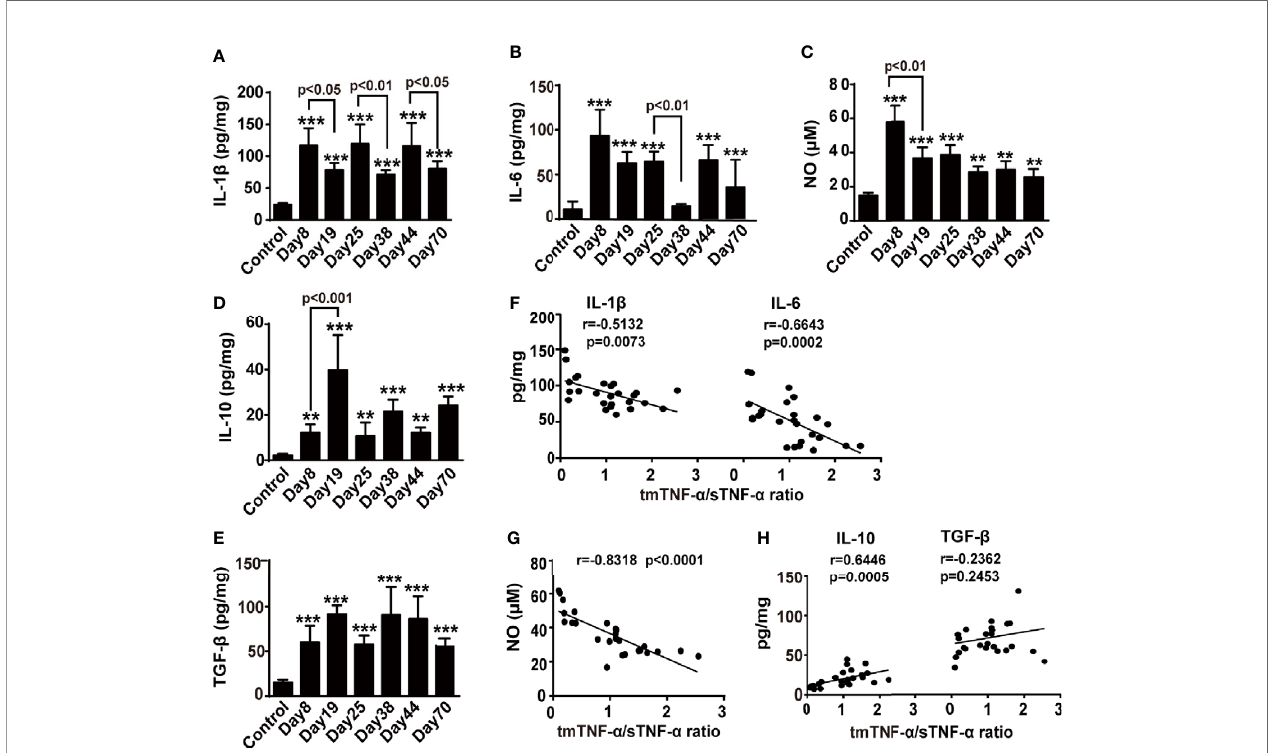
FIGURE 4 | The tmTNF- a /sTNF- a ratio negatively correlates with proin fl ammatory mediators but positively correlates with IL-10. Mice were treated with AOM and DSS as described in Figure 1A (n = 5-8, each group). Concentrations of IL-1 b (A) , IL-6 (B) , IL-10 (D) , and TGF- b (E) in colonic tissue homogenates detected at indicated time points by ELISA. The levels of NO (C) in colonic tissue homogenates measured by Griess method. The correlation of tmTNF- a /sTNF- a ratio with concentrations of IL-1 b and IL6 (F) , or NO (G) , or IL-10 and TGF- b (H) [n = 26, except IL-10 (n = 25)]. All values represent the mean ± SEM. **P < 0.01, ***P < 0.001 versus